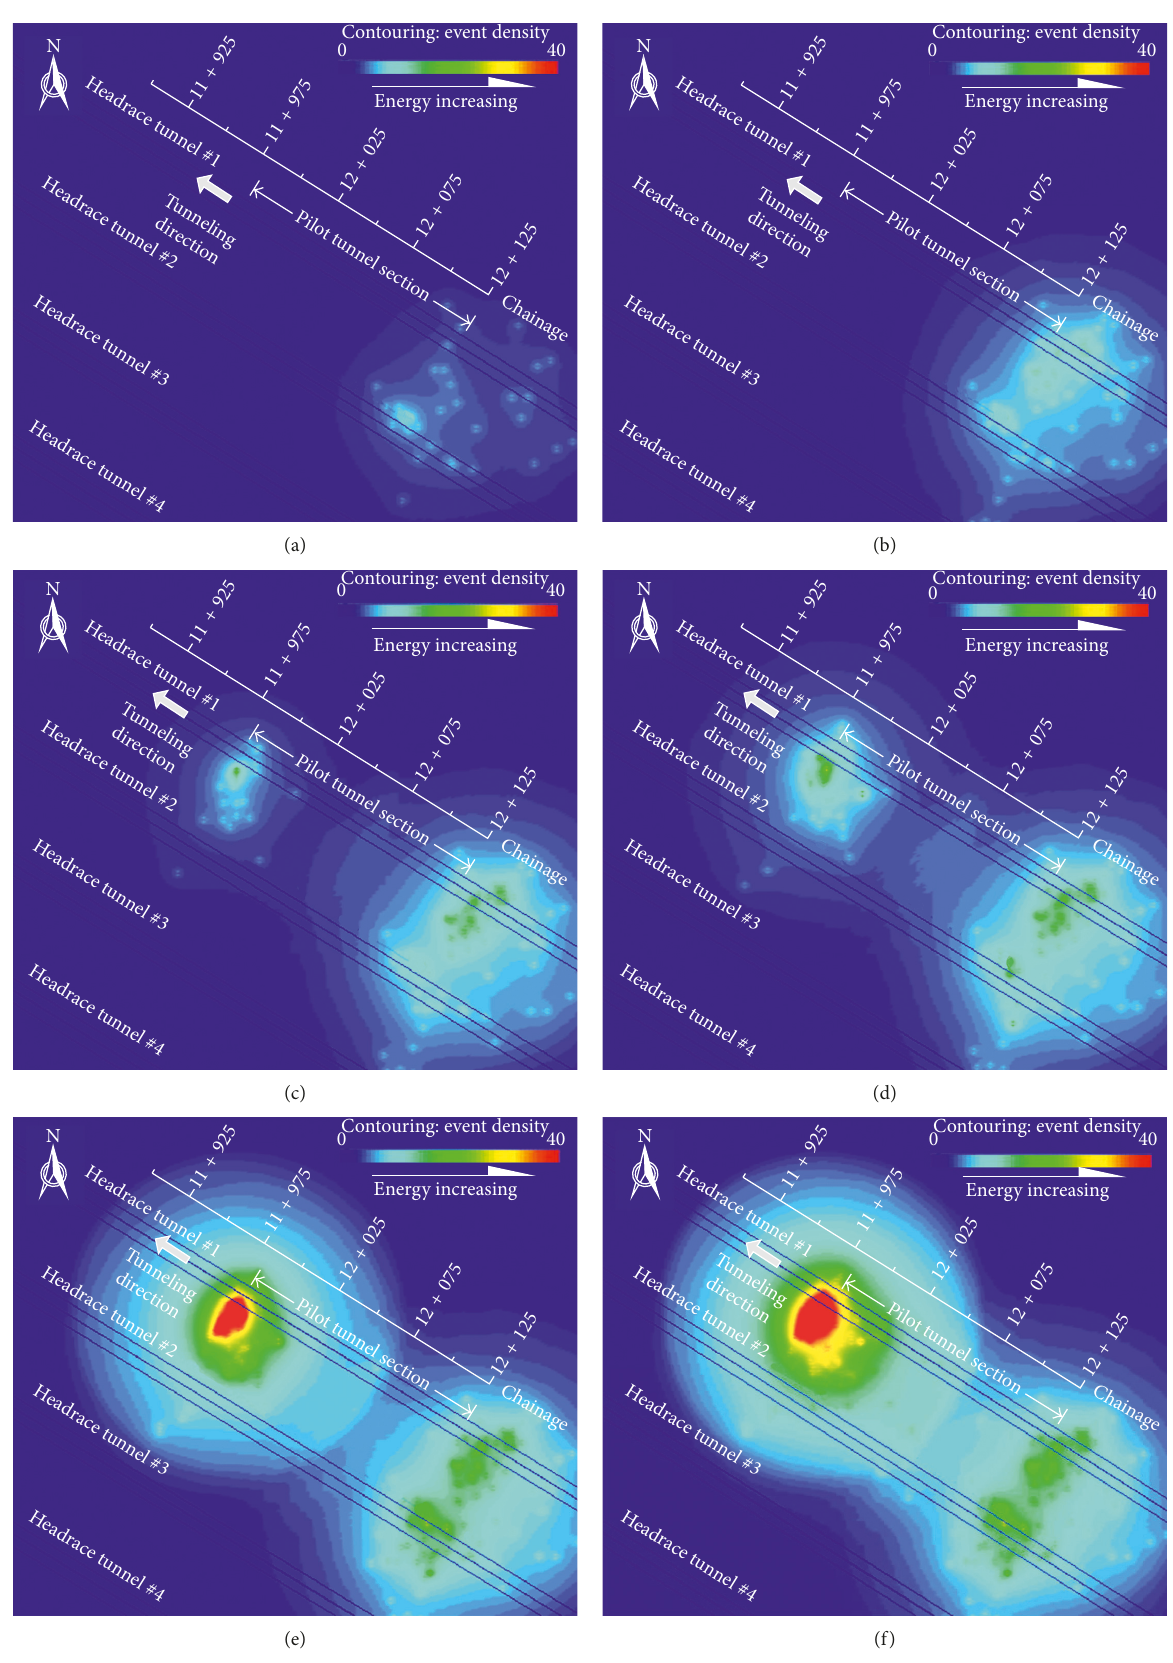
Figure 13: The accumulative density nephogram of MS events during the TBM excavation. (a) 21 May, 2010. (b) 24 May, 2010. (c) 27 May, 2010. (d) 30 May, 2010. (e) 5 June, 2010. (f) 17 June,